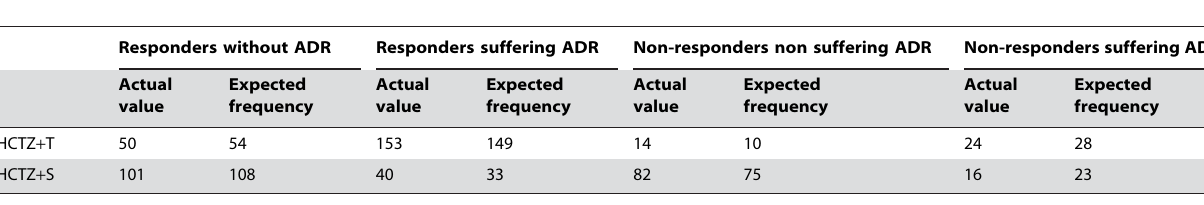
Table 10. Comparison of real and expected frequencies with data extracted from a clinical trial in which hydrochlorothiazide plus a test drug (T) was compared with hydrochlorothiazide plus a standard drug (S) in hypertensive patients